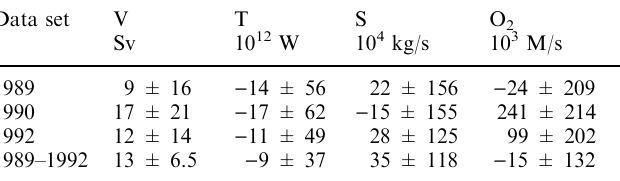
Table 5. Tracer transports without velocity data Data set